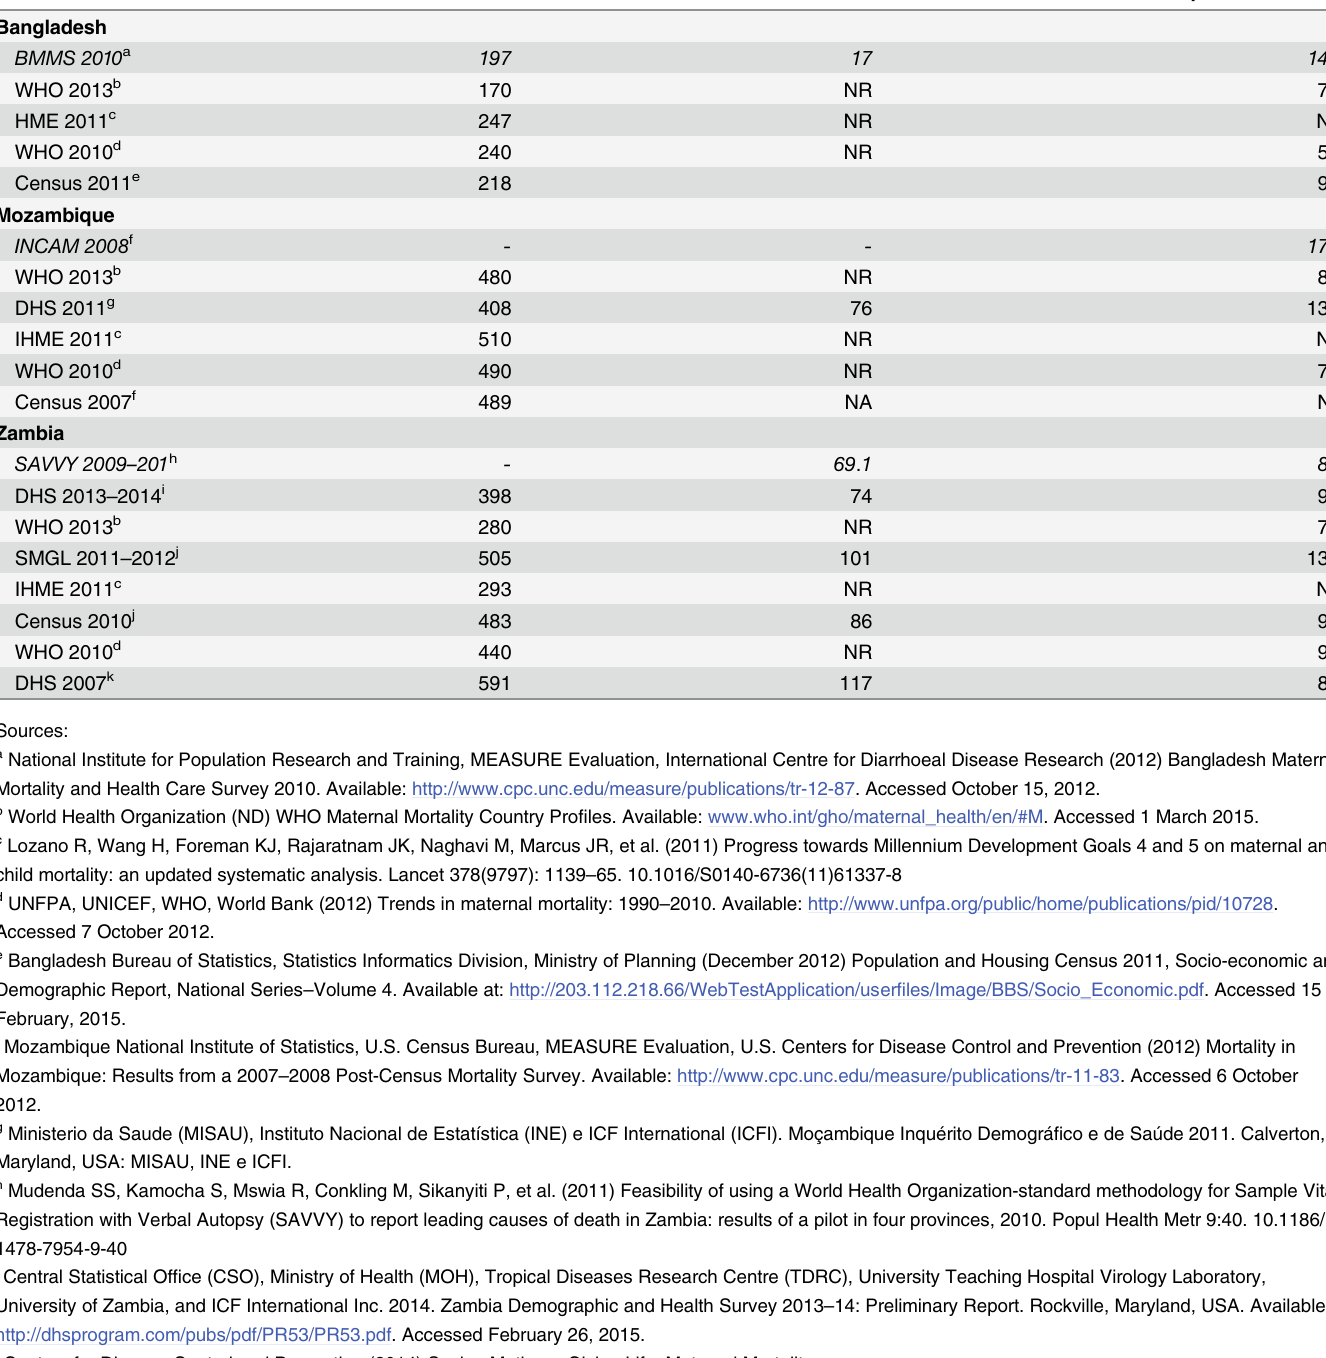
Table 6. Comparison of Maternal Mortality Estimates: Zambia, Bangladesh, Mozambique. MMR MMRate Proportion